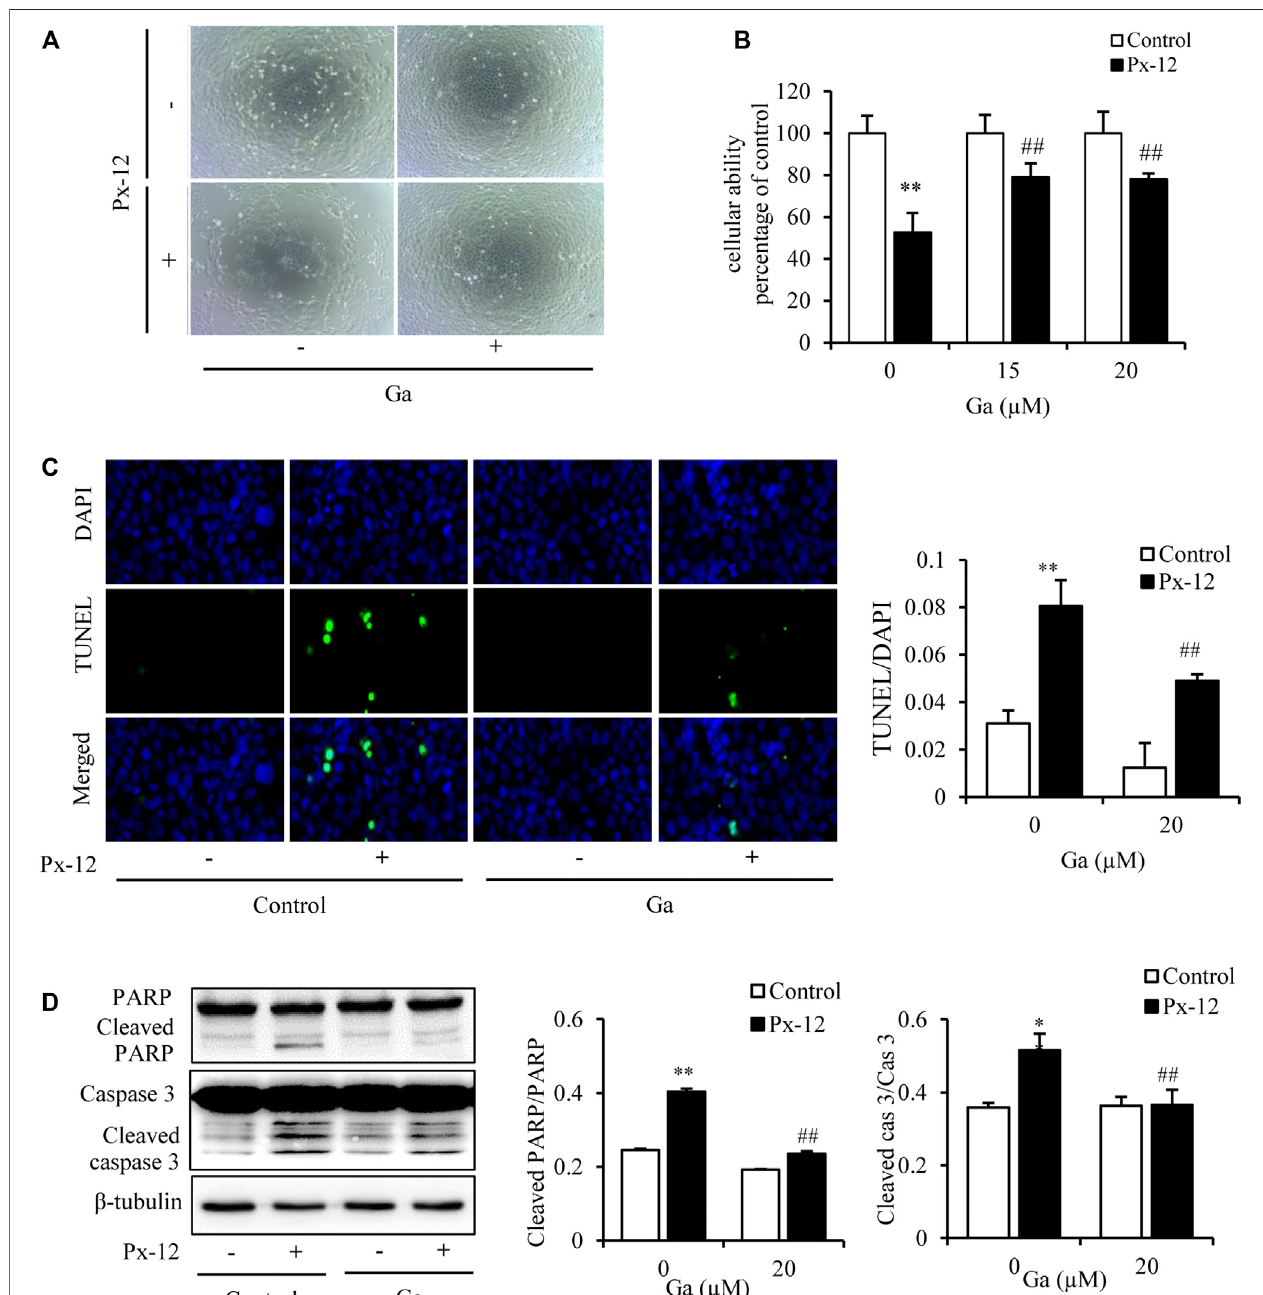
FIGURE 2 | Inhibition of the gap junction alleviates Px-12-induced cell oxidative injury. (A) The role of 18 α -glycyrrhetinic acid (Ga) on morphological changes triggered by Px-12. NRK-52E cells were pretreated with Ga (20 μ M) for 1 h and then challenged with Px-12 (10 μ M) for another 24 h. Cell morphology is shown, as determined using an inverted microscope ( × 100). (B) Effects of Ga on cell viability. NRK-52E cells were pretreated with Ga (15 and 20 μ M) for 1 h and then challenged with Px-12 (10 μ M) for another 24 h. Then, cell viability was evaluated using a Cell Counting Kit-8 (CCK-8) assay. Data are expressed as the percentage of living cellsvs.theuntreatedcontrol(mean ± SD, n (cid:2) 6).* p < 0.01vs.thecontrol.## p < 0.01vs.Px-12inthecontrol. (C) ApoptosisstainingofNRK-52Ecells.NRK-52E cellsin 96-well plate were pretreated with Ga (20 μ M) for 1 h and then incubated with Px-12 for another 24 h. Then, apoptotic cells were evaluated using DT-mediated dUTP nickendlabeling(TUNEL)and4,6-diamidino-2-phenylindole(DAPI)staining(magni fi cation, × 400).Theratioofpositivecellsisshownontheright(mean ± SD, n (cid:2) 3;** p < 0.01 vs. the control, ## p < 0.01 vs. Px-12 in the control). (D) The role of Ga on NRK-52E cell apoptosis-related molecules. NRK-52E cells in six-well plates were pretreated with Ga (20 μ M) for 1 h and then challenged with Px-12 for another 24 h. Cellular lysates were then analyzed by western blotting to detect poly (ADP-ribose) polymerase(PARP),cleavedPARP,caspase-3,andcleaved caspase-3.Densitometricanalysisofcleaved PARPandcaspase-3areshownontheright(mean ± SD, n (cid:2) 3; ** p < 0.01 vs. the control, ## p < 0.01 vs. Px-12 in the control).